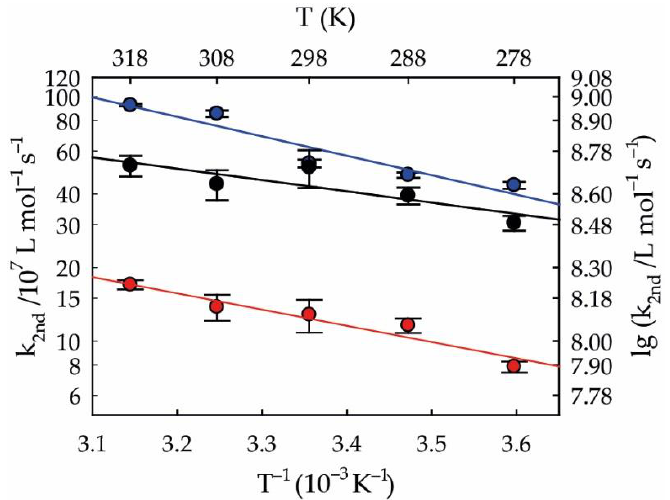
Figure 2. Arrhenius plot of the OH radical reactions of the speciation AH 2 (red), AH − (black), and A 2− (blue) of succinic acid.